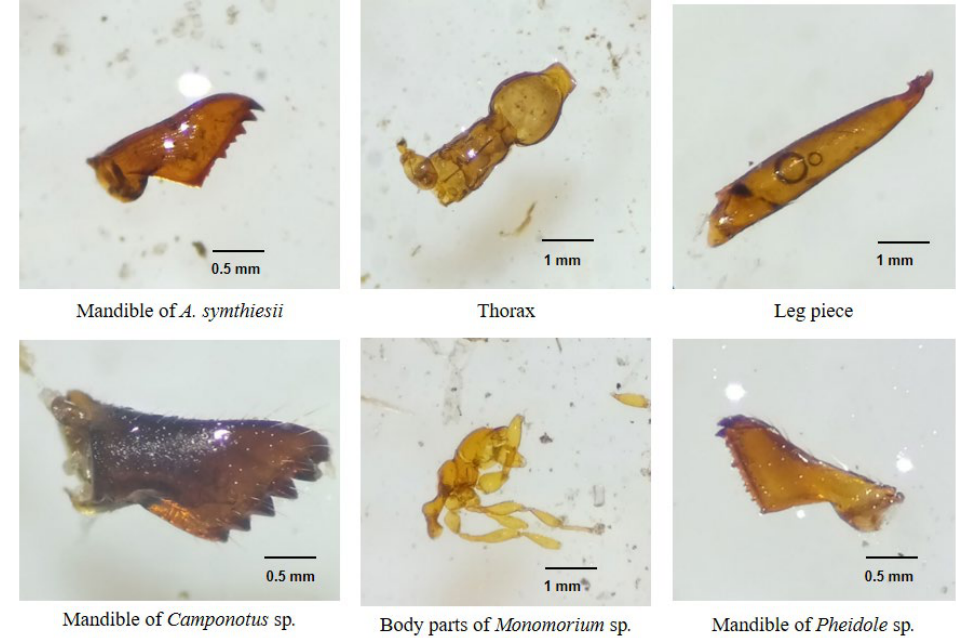
Figure 7. Ant body parts found in the fecal samples of the Chinese pangolin in Chandragiri Municipality, Nepal.